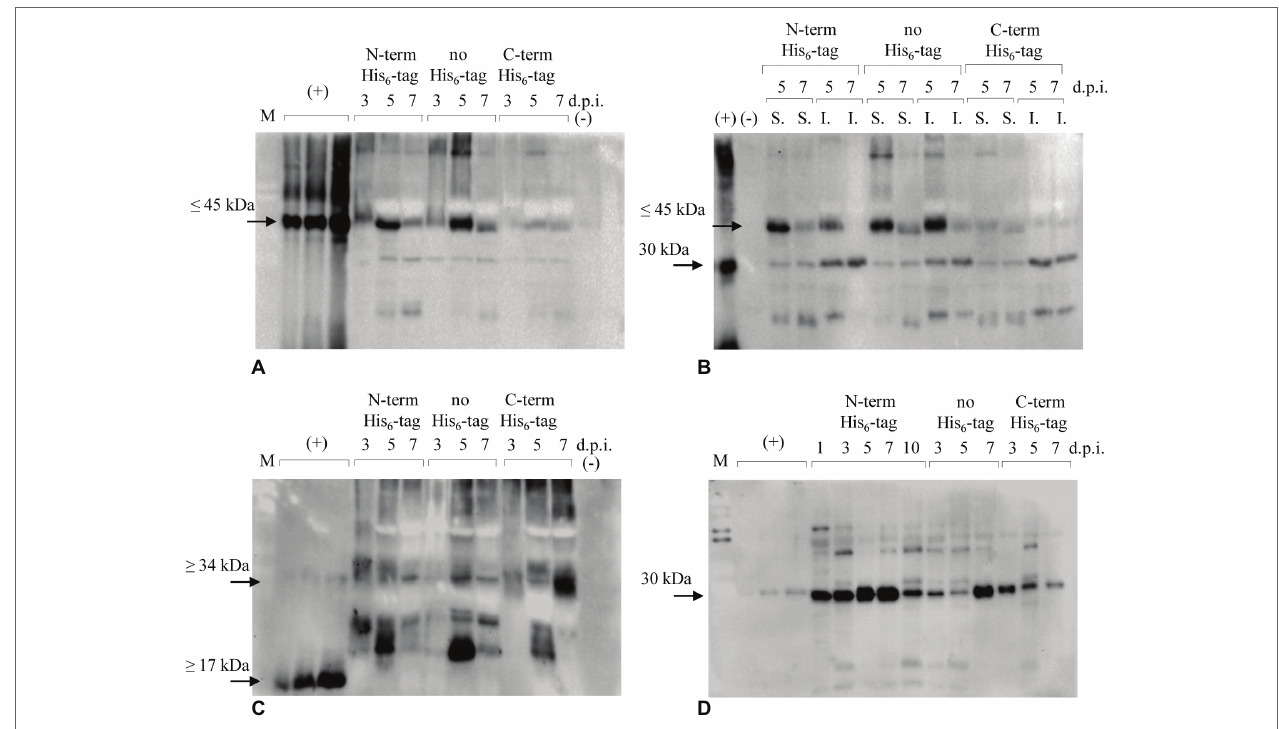
FIGURE 2 | Immunoblotting analysis of accumulation of recombinant E7*-SAPKQ, E7*, and SAPKQ. (A) Accumulation of recombinant E7*-SAPKQ in total extracts of N. benthamiana infiltrated leaves (anti-SAP polyclonal antibody). (+), His 6 -E7*-SAPKQ from E. coli (25, 50, and 100 ng); (−), extract from leaves infiltrated with pEAQ-HT harboring an irrelevant gene; d.p.i., days post infiltration. (B) Soluble (S.) and insoluble (I.) fractions from leaves infiltrated with A. tumefaciens harboring